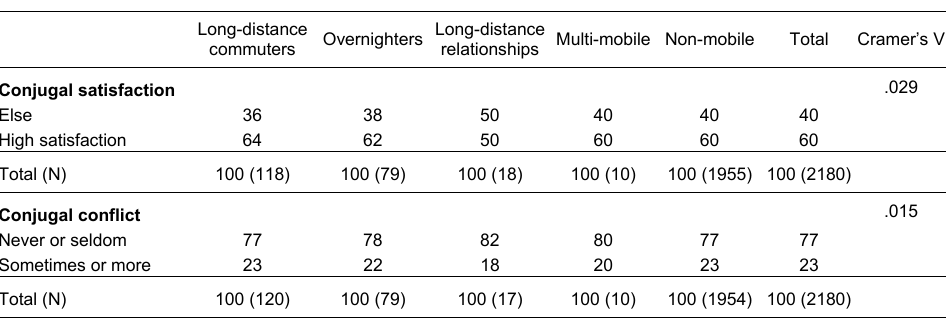
Table 1: Conjugal satisfaction and conjugal conflict by mobility types (in %) Long-distance